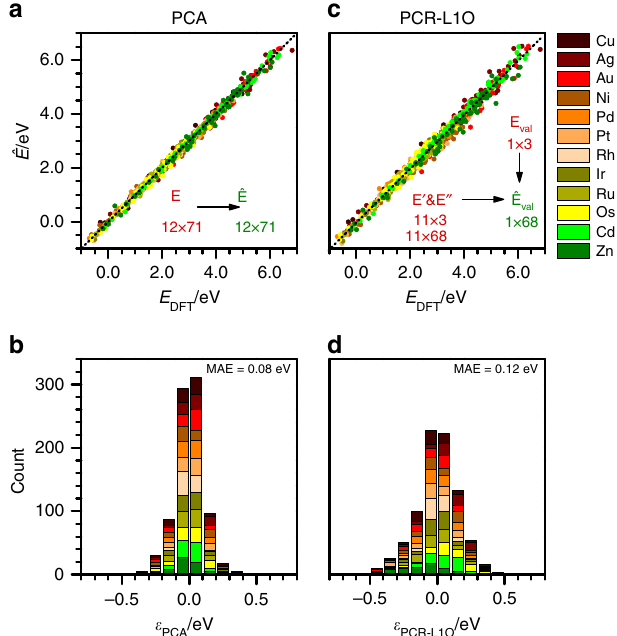
Fig. 4 Accuracy assessment of PCA and PCR. a Error distribution and b cumulative errors for the PCA, taking the DFT data of the 71 molecules on the 12 metals. c , d The corresponding values for PCR-L1O, using only O*, *OH, and *CCHOH as predictors, and leaving-one-metal-out of the pool (L1O). The inset shows the size of the corresponding input (red) and